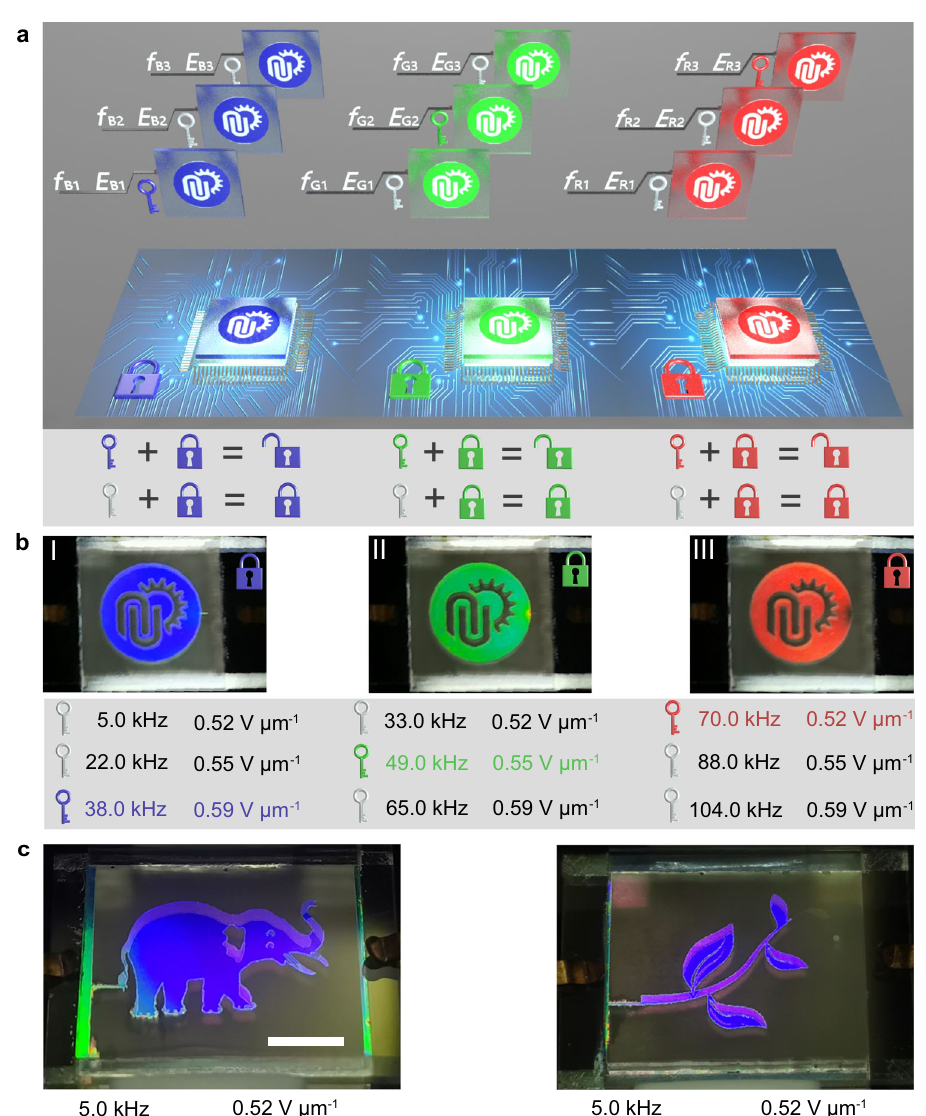
Fig. 3 Active information encryption with the required images. a Schematic diagram of active information encryption by setting one of a series of electric fi elds with different strengths and frequencies corresponding to a certain re fl ection color image as the encryption key of an information. b Images with a certain re fl ection color were obtained through a series of electric fi elds. c The images with a three-dimensional visual effect are shown with a slightly oblique viewing angle. The scale bar represents 5